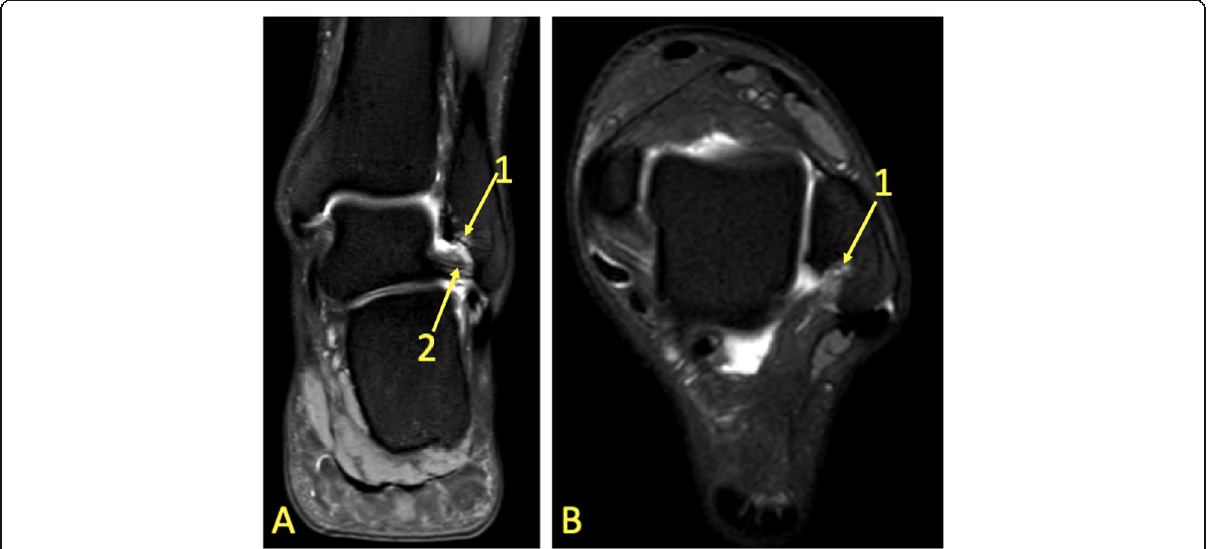
Fig. 5 A 42-year-old male with 9-month history of ankle pain and suspicion of an osteochondral lesion. MRI ( a , b ) revealed traction cysts at the insertion of the posterior talofibular ligament